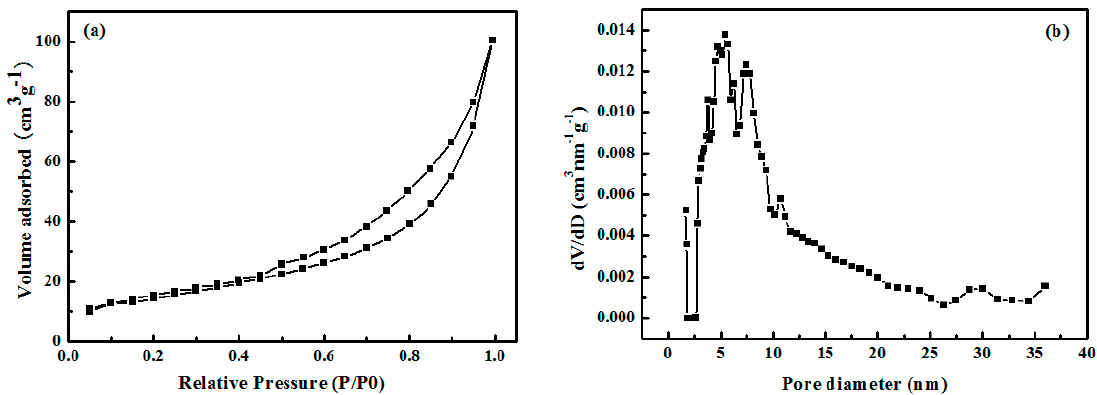
Figure 5. N 2 adsorption-desorption isotherm ( a ); and the corresponding pore size distribution curve ( b ) of the pristine palygorskite powders.